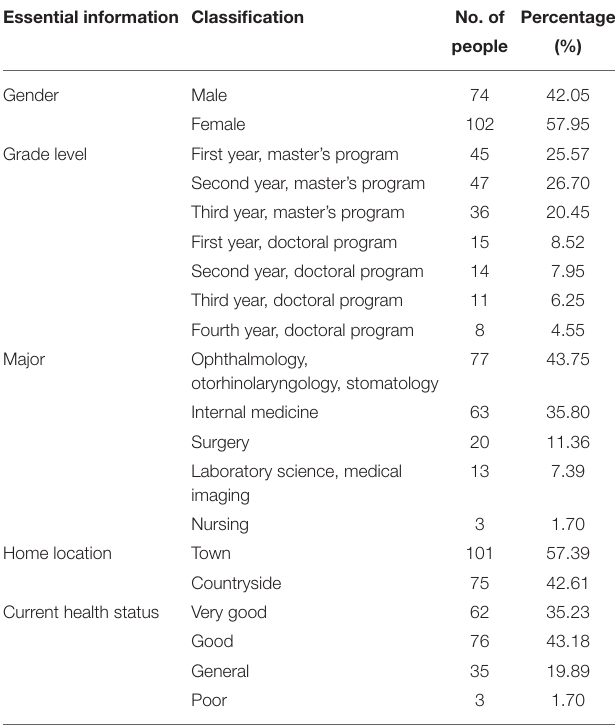
TABLE 1 | Demographic characteristics of the study subjects. Essential information